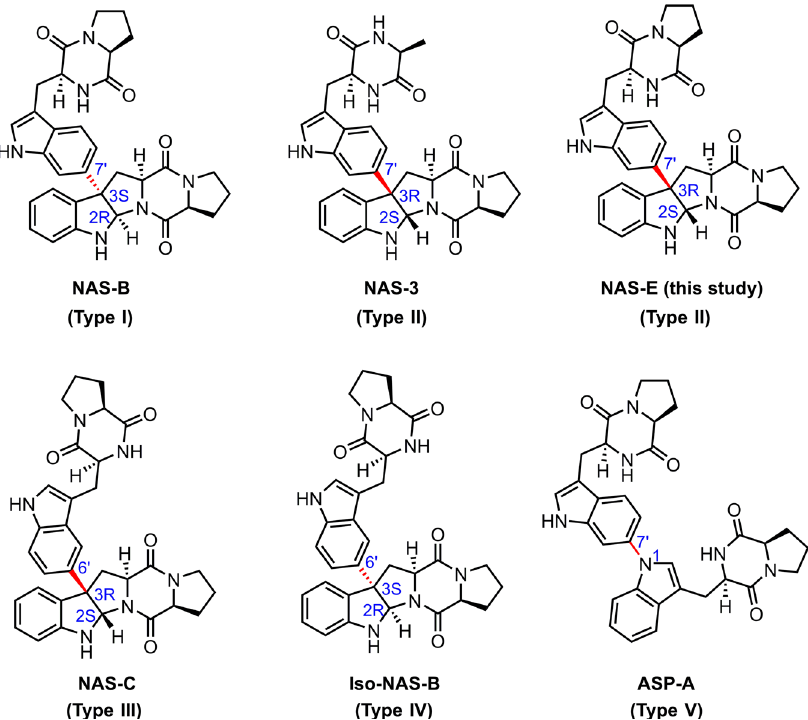
Fig. 1 The structures of representative bacterial HTDKP natural products. The bond connectivity of two DKP moieties (red) and the C2-C3 chirality (blue labels) are highlighted. NAS-E was produced in this